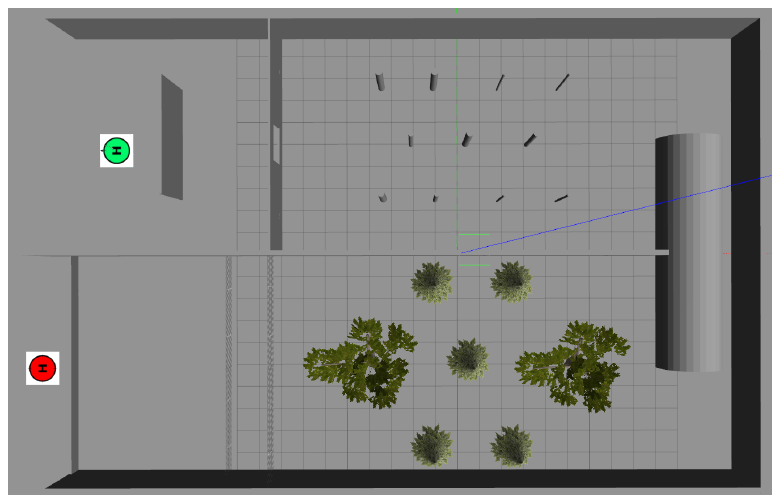
Figure 6. Training environment (top view).